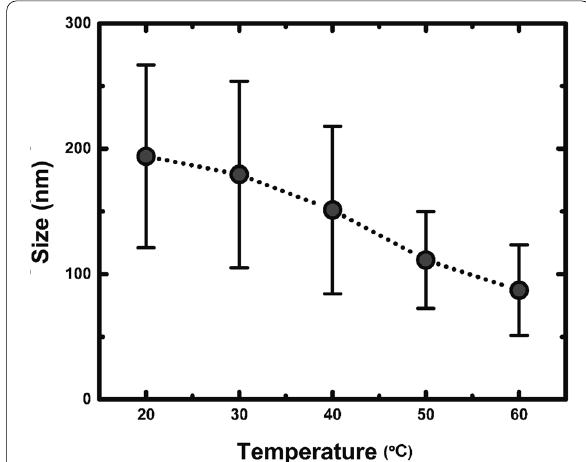
Fig. 7 The size of transitioned vesicles depending on temperature. The effective q-value of bicelle sample was 1.5 and the stirring time was 5